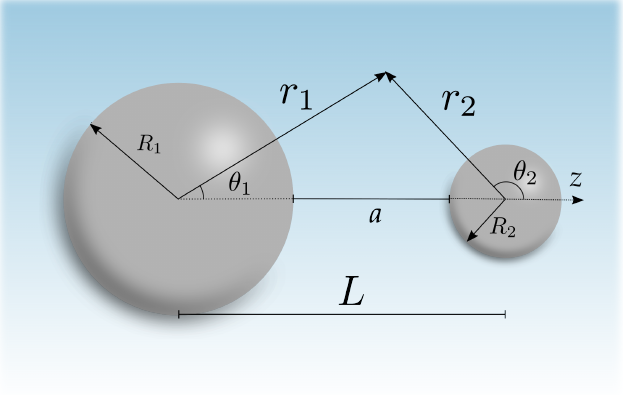
Figure 1. Description of the geometry with two solid spheres of radii R 1 and R 2 separated by a center- to-center distance L along the z -axis. We also indicate the surface-to-surface distance a = L A generic point can be described using either sphere center: r 1 ( r 2 ) is a vector from the center of the sphere 1 (2) to the